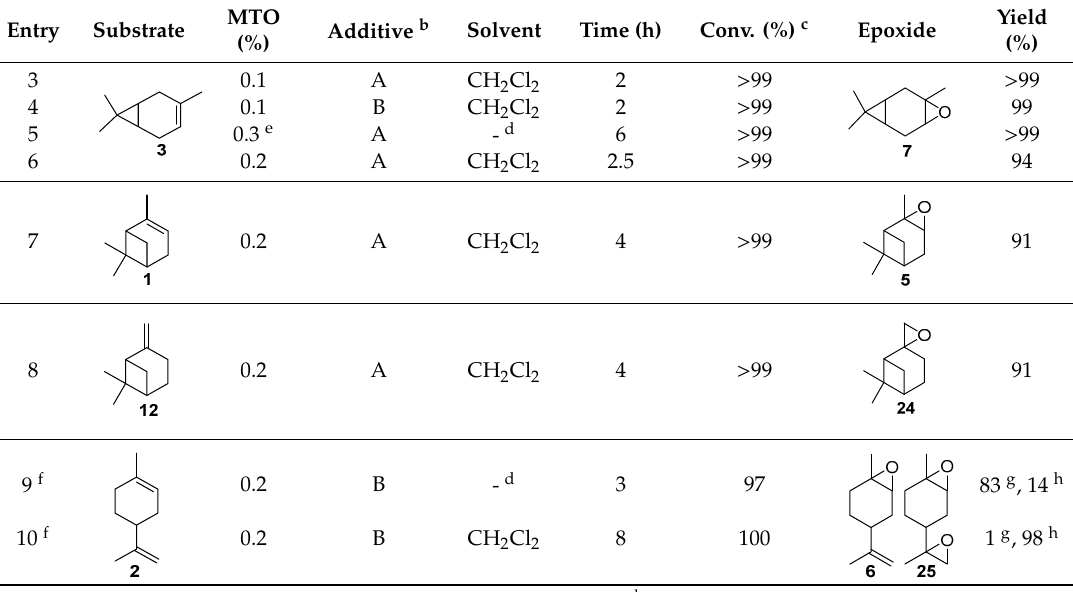
used. d Reaction without organic solvent. e Addition of 0.2 mol% MTO initially, and additional MTO (0.1 mol%) after 1 h. f Reaction at 15 ◦ C with 25 mmol H 2 O 2 . g 1,2-epoxide. h